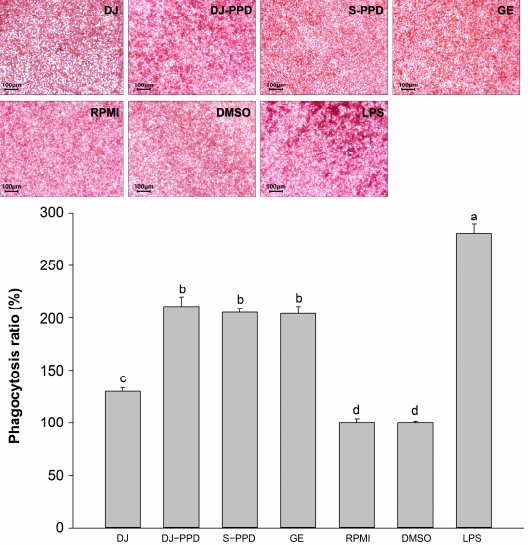
Figure 6. Increasing phagocytic activity in RAW264.7 cells treated with DJ extract, DJ-PPD extract, S-PPD, and GE extract. Cells were incubated for 24 h after pretreatment with each sample. DJ, DJ- PPD, and GE concentrations were 100 µg/mL, whereas the S-PPD concentration was 700 pg/mL. DMSO and LPS concentrations were 0.1% and 1 µg/mL, respectively. Data are shown as means ± standard deviations. Different lowercase letters indicate significant differences among treatments at p < 0.05.